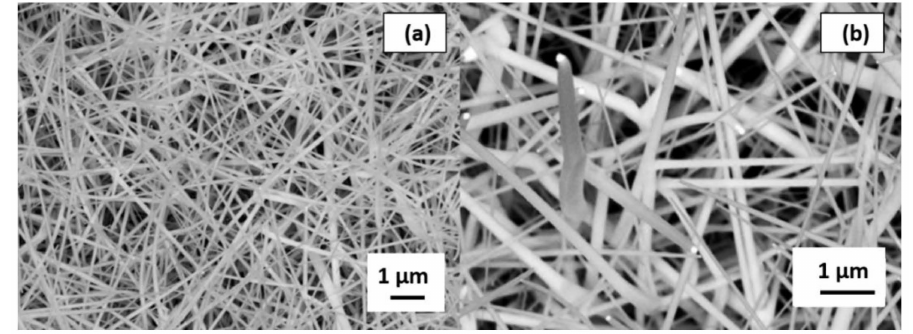
Figure 9. SEM images of Zn-In 2 O3 NWs at ( a ) low and ( b ) high magnification. Reprinted from [94] with permission from